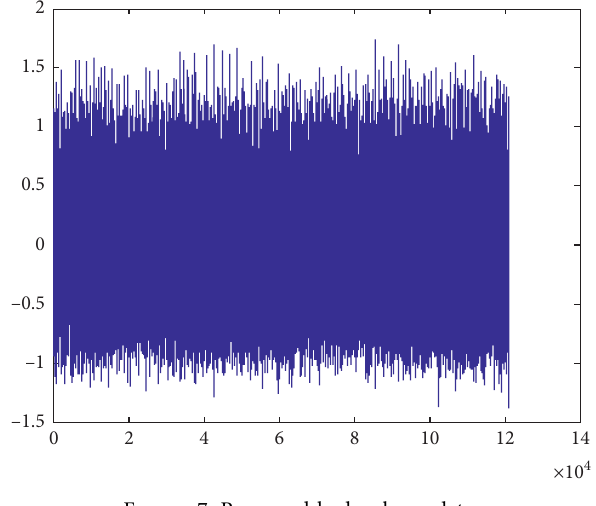
Figure 7: Processed hydrophone data.